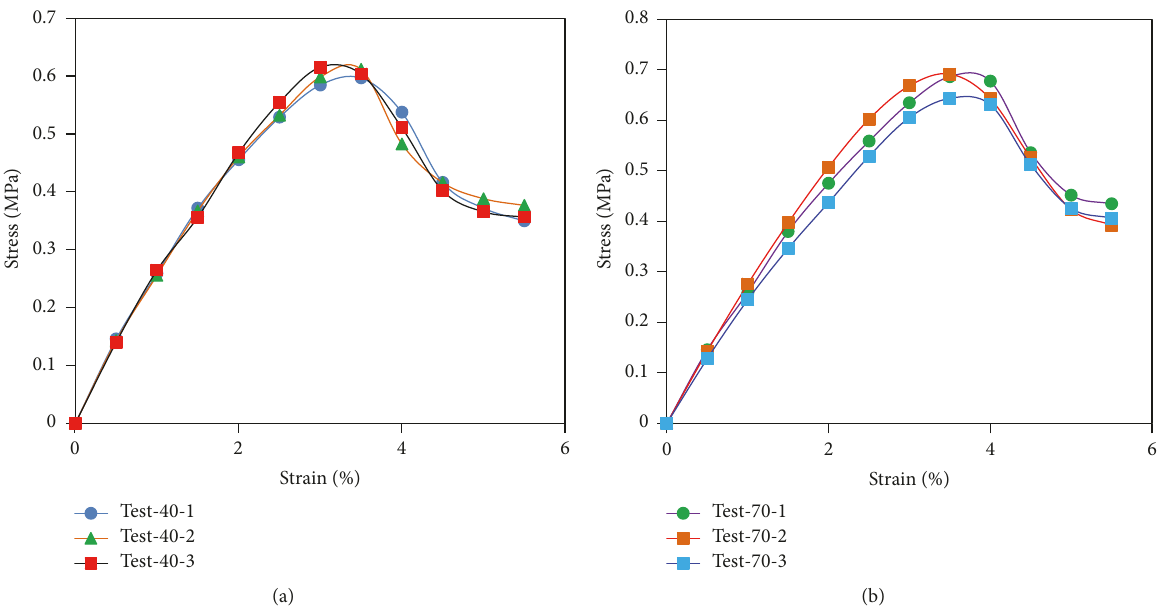
Figure 5: Stress-strain curves for cemented mercury slag: (a) 40 years and (b) 70 years.